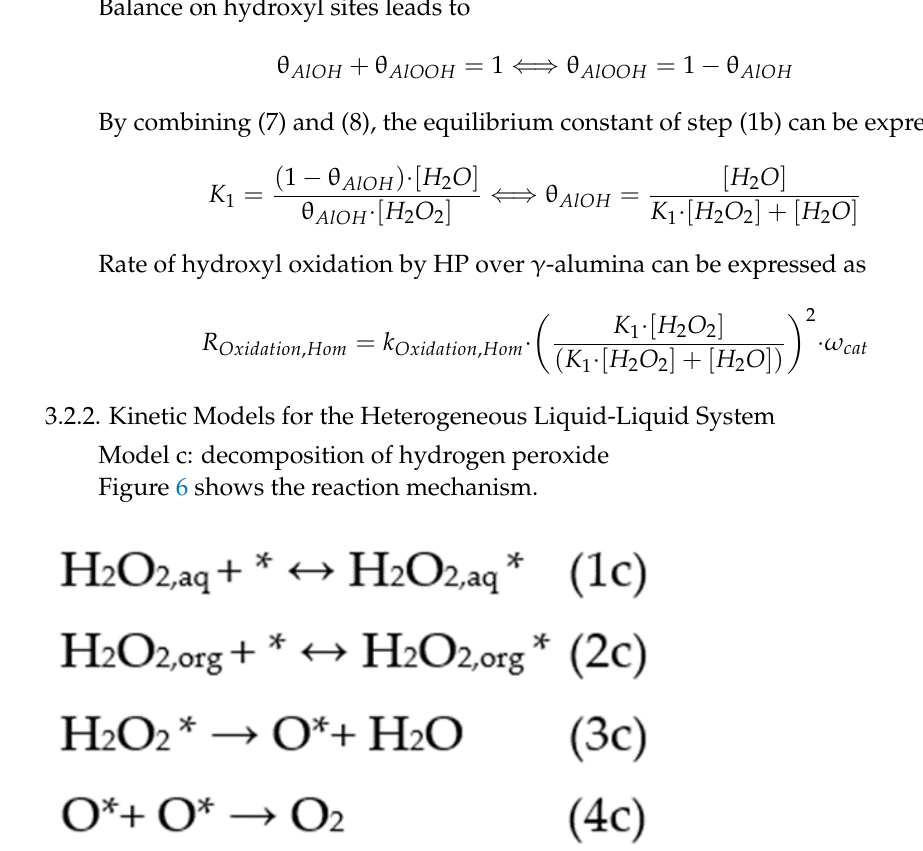
Figure 6. Decomposition of hydrogen peroxide in the heterogeneous liquid-liquid system.